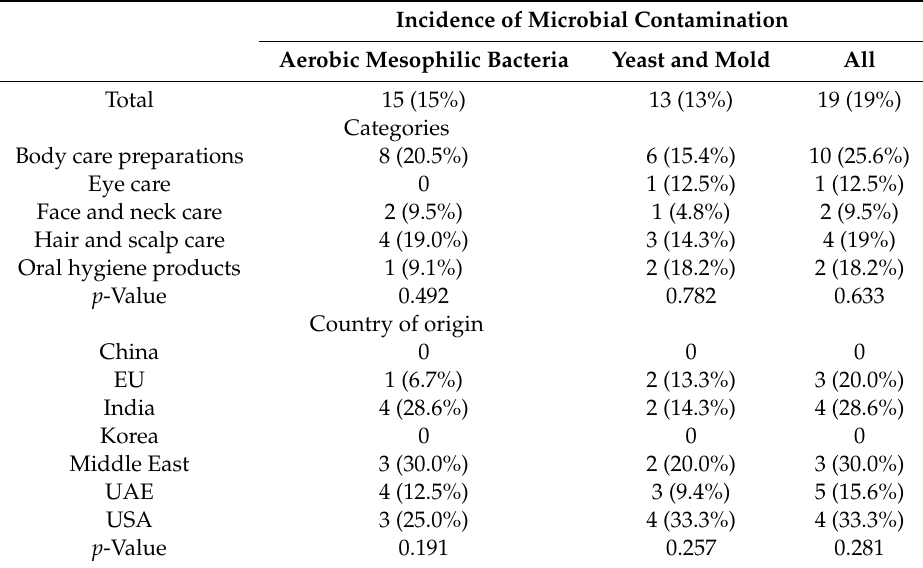
Table 5. Incidence of microbial contamination according to sample